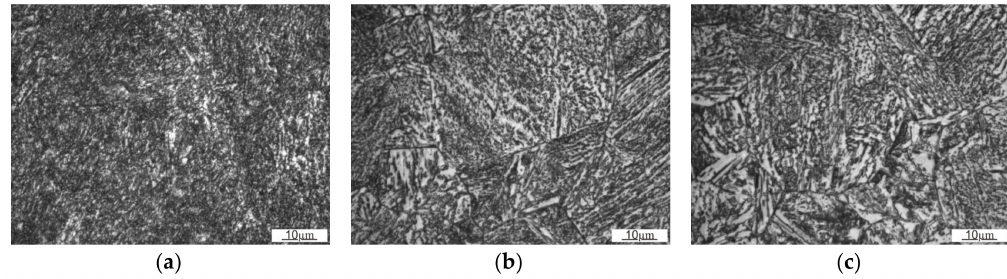
Figure 13. Change of the microstructure in a line perpendicular to surface A, row one, at di ff erent distances. ( a ) 1.5 mm; ( b ) 4.5 mm ( c ) 8.5